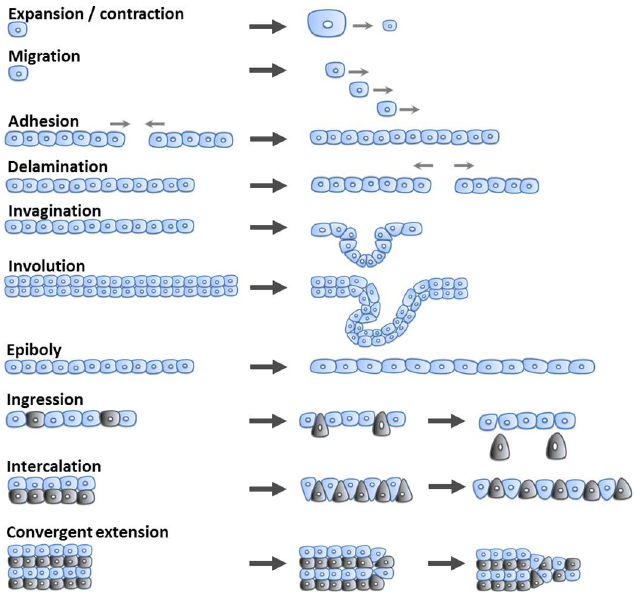
Fig 1. Outline of some of the fundamental cell behaviors that take place during morphogenesis. Duringexpansion/contractioncells changetheir volume. During migration cells are able to travel to different locations.Cell adhesioninvolvesthe capabilityof cells to bind to other cells or substrate. Cell delamination involvessplittingapart groups of cells. Cell invaginationis a type of folding that creates a pocket. Cell involution is the generationof an inward curvature that results in a new underlying layer. Cell epibolyinvolves spreading of cell layers. During ingression cells detach from a main structure to migrate. Duringintercalation cells from different rows interpolate creating longerbut thinner arrays. Convergent extensioninvolvescells that converge in one direction to achieveextensionin another perpendicular